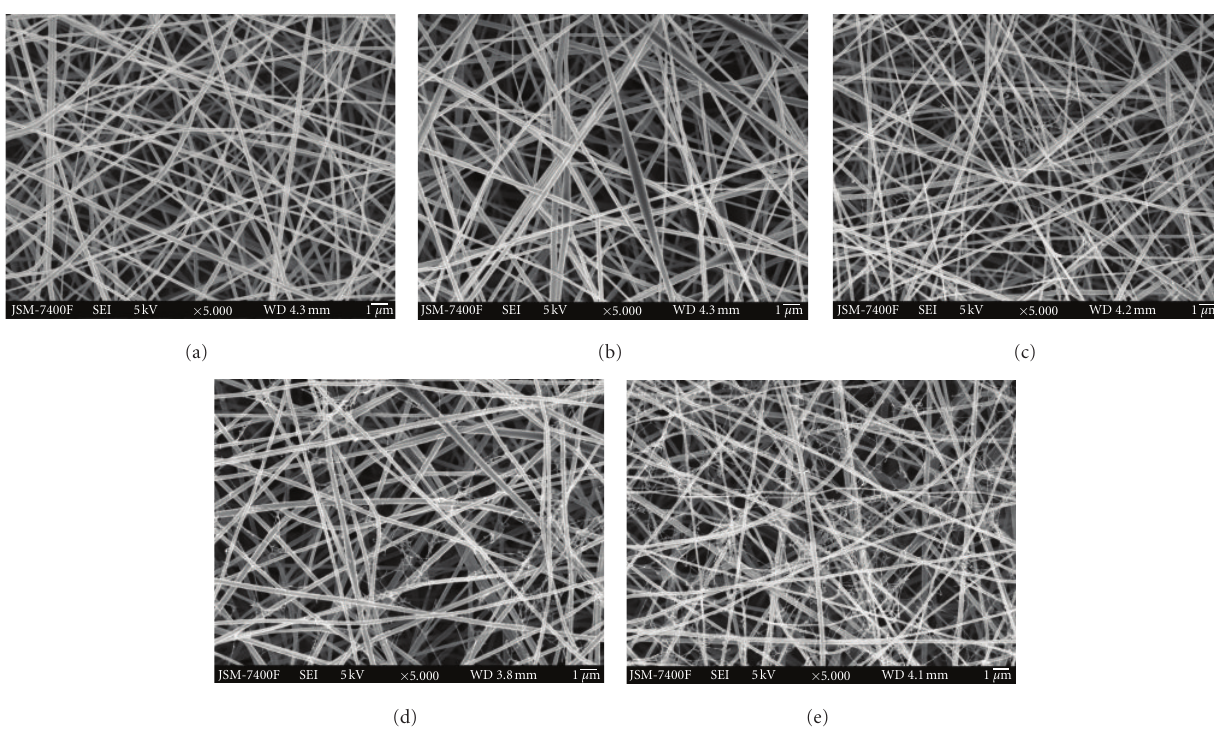
Figure 1: SEM image of electrospun (a) Zein nanofiber, (b) Zein-0.2wt% SWCNTs, (c) Zein-0.5 wt% SWCNTs, (d) Zein-0.8 wt% SWCNTs, and (e) Zein-1wt% SWCNTs nanocomposite sca ff olds (scale Bar: 1 μ ).